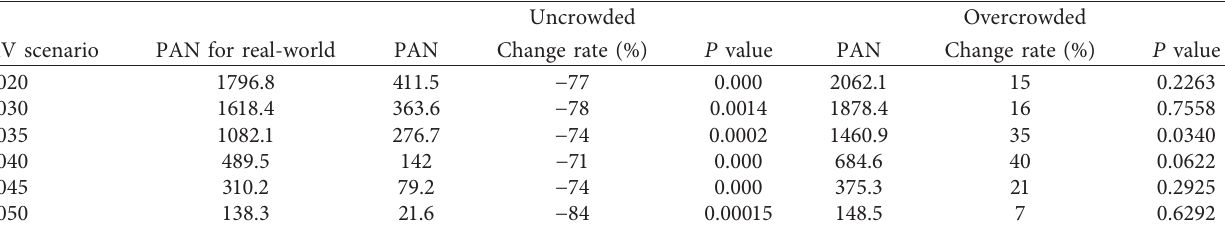
Table 8: The sensitivity analysis of potential accident number for each demand scenario compared to the real-world scenario at the Sattarkhan